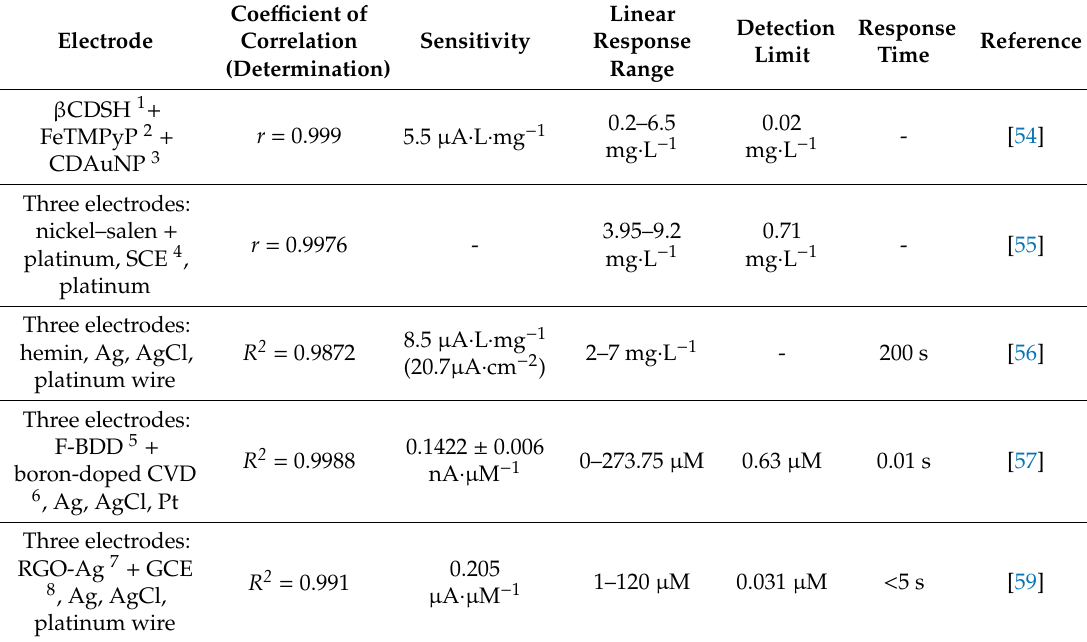
Table 1. Comparison of polarographic electrochemical dissolved oxygen